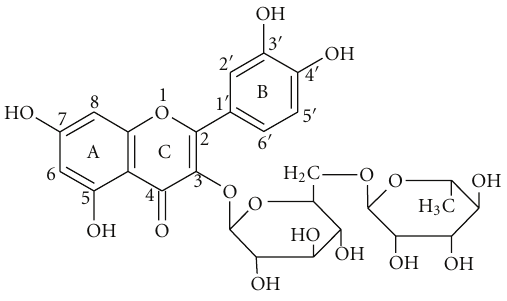
Figure 1: Chemical structure of